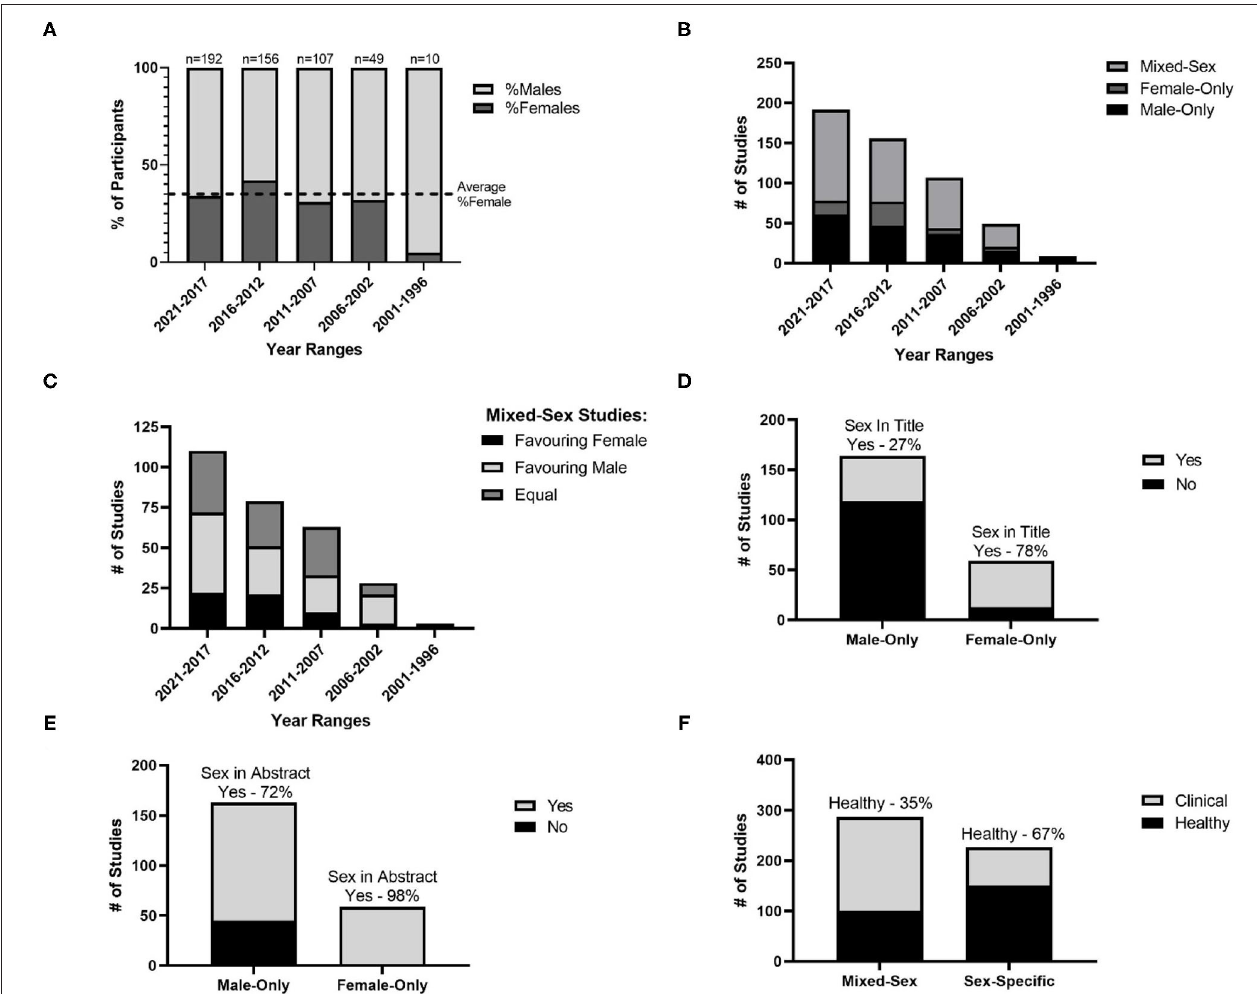
FIGURE 3 | Sex-specific inclusion. (A) Average percentage of female and male participants from studies in cohorts of 5 years with the dotted line as the average over all studies; (B) Number of male-only, female-only and mixed-sex studies in cohorts of 5 years; (C) Number of mixed-sex studies with equal male-female participants, unequal participants favoring females and unequal participants favoring males, over cohorts of 5 years; (D) Number of male-only and female-only studies including sex in the article title; (E) Number of male-only and female-only studies including sex in the article abstract; (F) Number of studies in mixed-sex and sex-specific groups for healthy and clinical